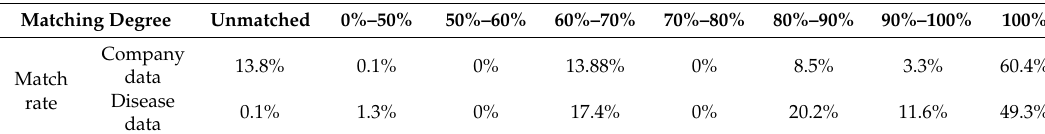
Table 1. Experimental results.